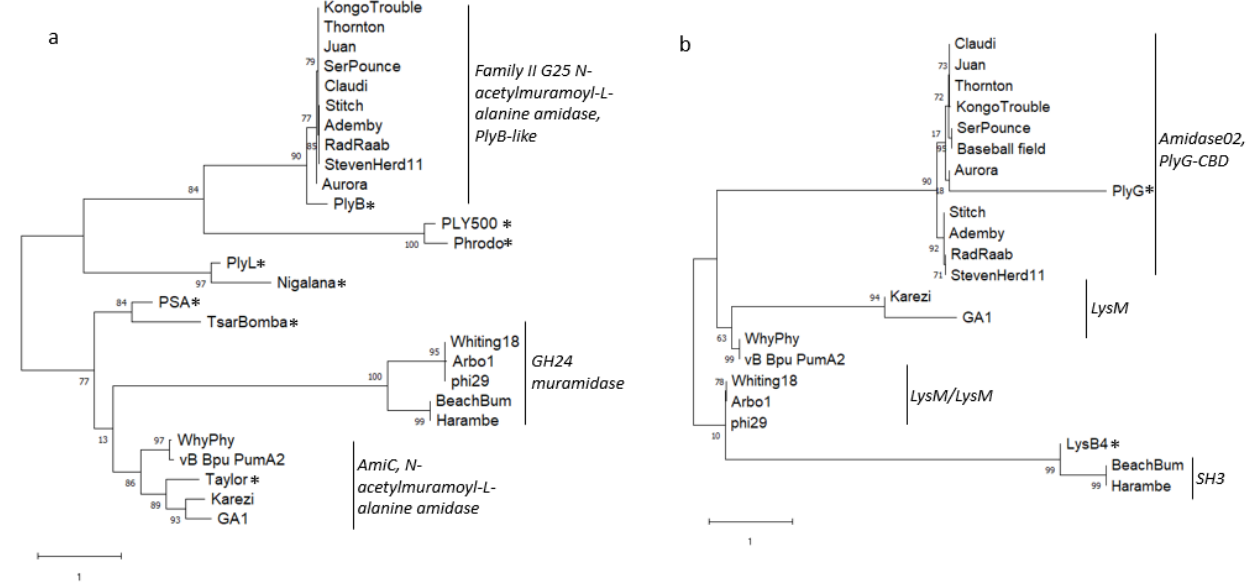
Figure 6. Phylogenetic analysis of endolysin protein sequences. Protein sequences were analyzed separately by ( a ) enzymatically active domain (EAD) and ( b ) cell-wall binding domain (CWB)The trees with the highest log likelihood are shown. The tree is drawn to scale, with branch lengths measured in the number of substitutions per site. Bootstrap values indicate the percent of iterations producing replicate clade arrangements after 500 iterations. This analysis involved 26 (EAD) and 22 (CBD) amino acid sequences. There were a total of 208 (EAD) and 123 (CBD) positions in the final dataset. Asterisk (*) symbols are used to highlight endolysin sequences from myoviral genomes.